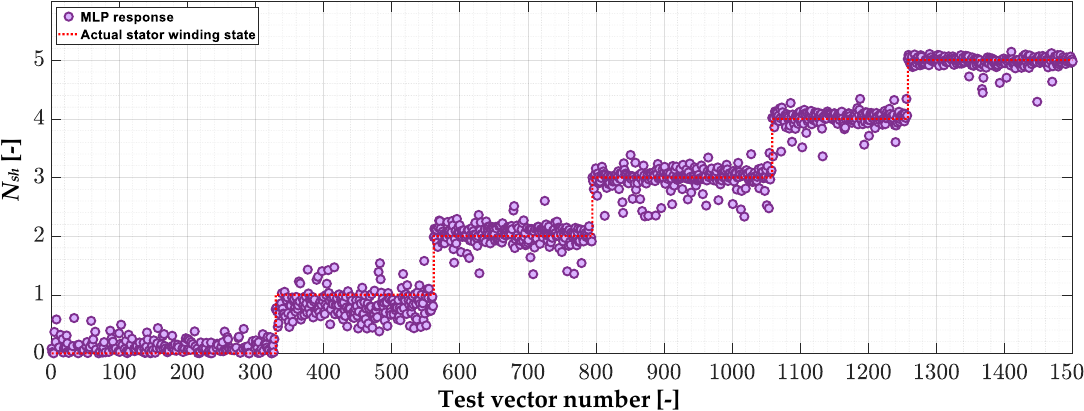
Figure 14. Loss (MSE) function during the training process of the MLP models with different struc- tures.